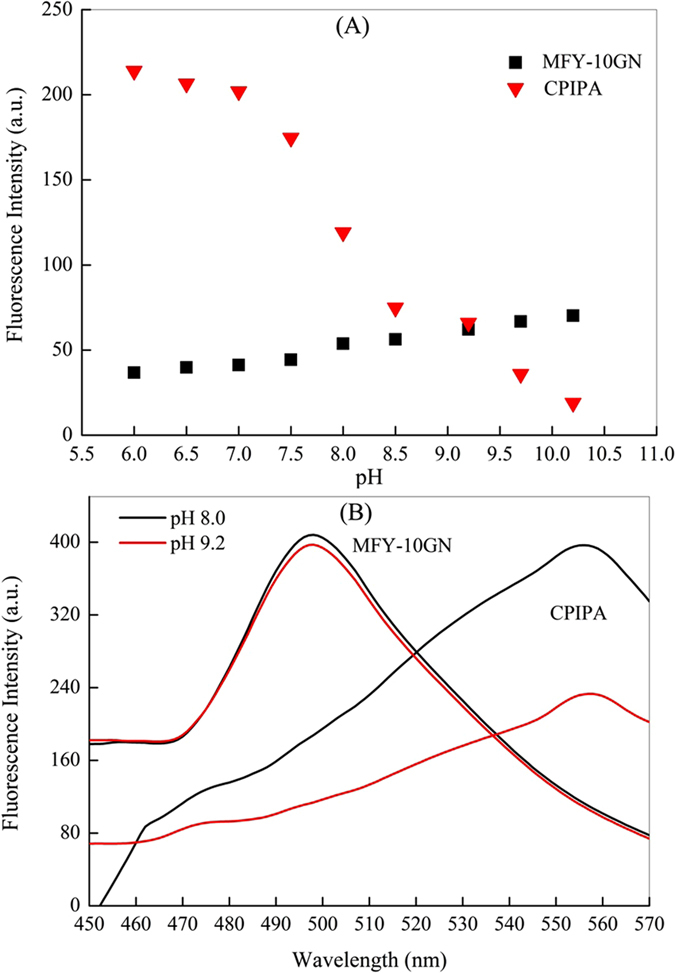
Emission intensities of CPIPA (▾, 550 nm excitation) and those of MFY-10 GN (◾, 389 nm excitation) under different pH (A); Excitationspectral data of the indicator dyes CPIPA (λexcitation-CPIPA = 554 nm) and emission spectra of the reference dye MFY-10 GN (λemission-MFY-10 GN = 502 nm) immobilized in the PVC matrix (B).